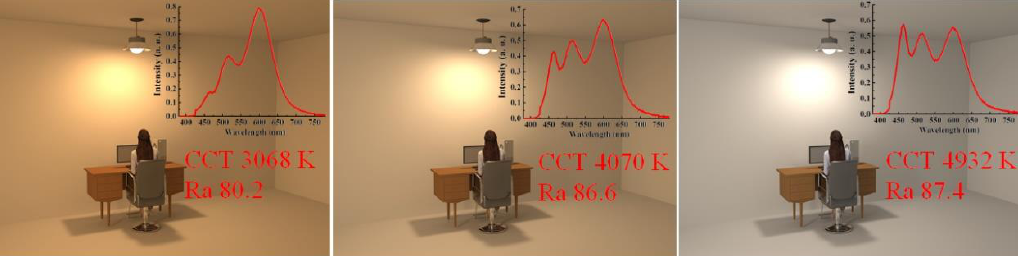
Figure 5. Illumination scenarios of the indoor area with WLEDs that produce different optical spectra, CCT, and Ra values.